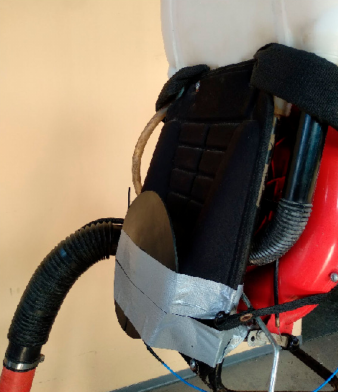
Figure 3. Position of the rubber pad containing the accelerometer, on the padded